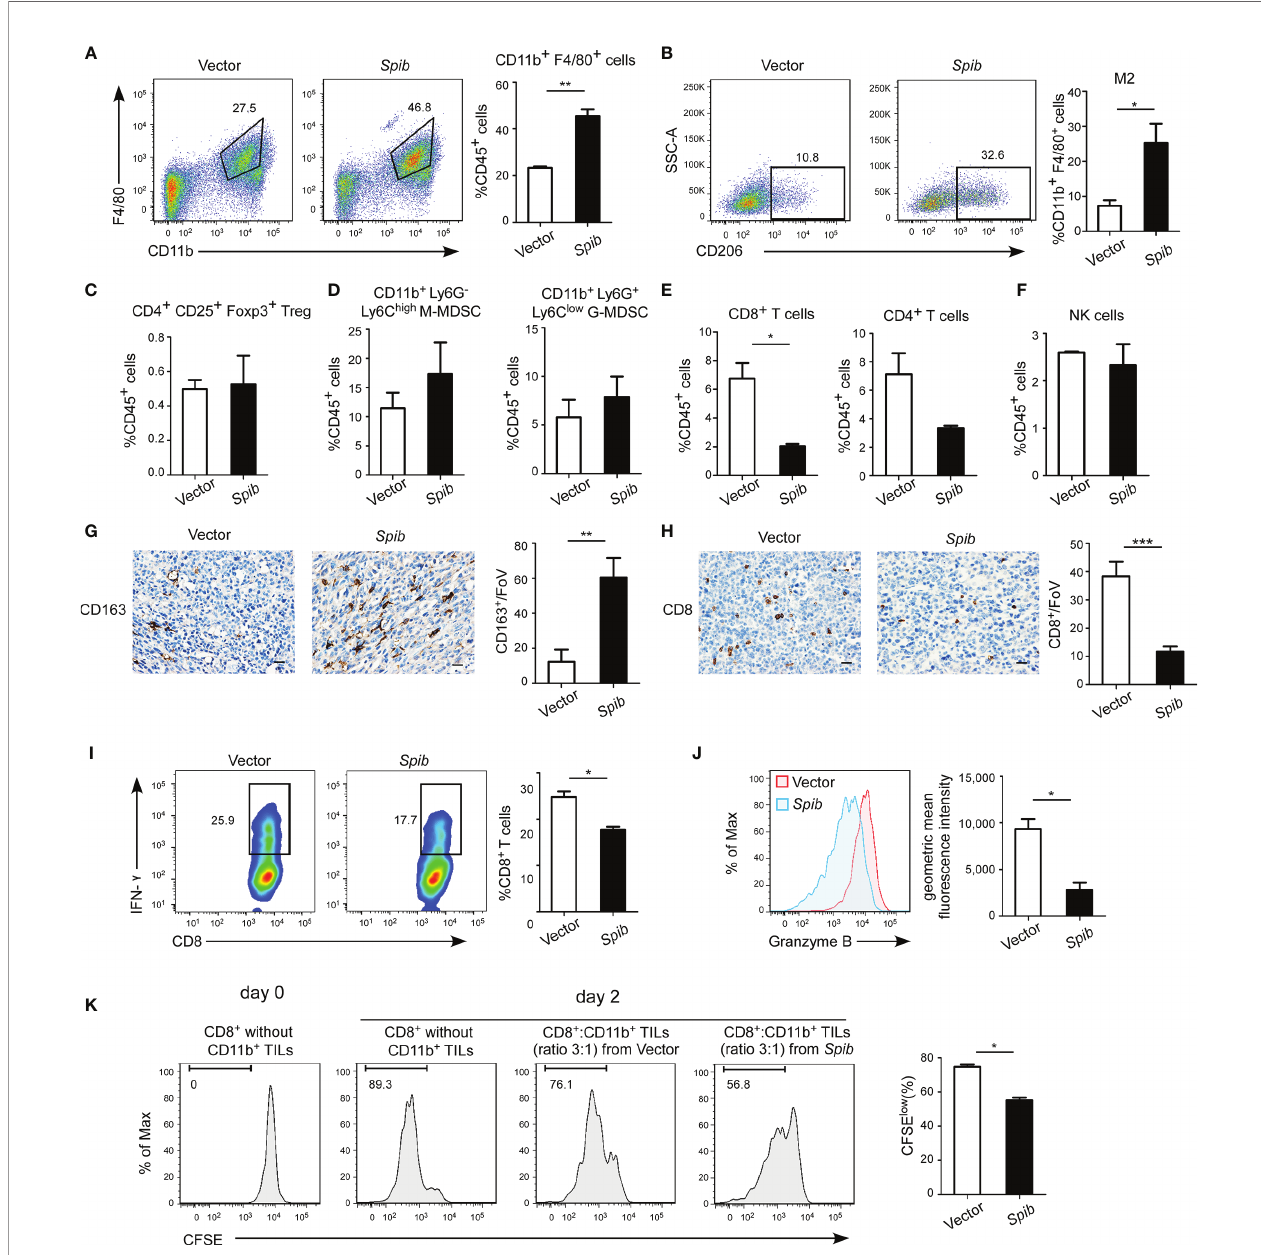
FIGURE 2 | Spib overexpression increases TAM in fi ltration in subcutaneous mouse models. (A) Representative fl ow cytometry pro fi les and percentages of TAMs in CD45 + TILs in subcutaneous tumors. n = 3-4. (B) Representative fl ow cytometry pro fi les and percentages of CD206 + cells in CD11b + F4/80 + cell populations in subcutaneous tumors. n = 3. (C) Quanti fi cation of Tregs in CD45 + TILs in subcutaneous tumors by fl ow cytometry. n = 3-4. (D) Quanti fi cation of monocytic myeloid- derived suppressor cells (M-MDSCs) and granulocytic myeloid-derived suppressor cells (G-MDSCs) in CD45 + TILs in subcutaneous tumors by fl ow cytometry. n = 3-4. (E) Quanti fi cation of CD8 + T cells and CD4 + T cells in CD45 + TILs in subcutaneous tumors by fl ow cytometry. n = 3-4. (F) Quanti fi cation of NK cells in CD45 + TILs in subcutaneous tumors by fl ow cytometry. n = 3-4. (G) Immunostaining with anti-CD163 was performed in subcutaneous tumors derived from LLC1 cells expressing Spib or empty vector. Scale bars, 20 µm. Left, representative pictures of CD163 staining. Right, quanti fi ed CD163 expression in subcutaneous tumors. FoV = fi eld of view. n = 3 mice for each group. (H) Immunostaining with anti-CD8 was performed in subcutaneous tumors derived from LLC1 cells expressing Spib or empty vector. Scale bars, 20 µm. Left, representative pictures of CD8 staining. Right, quanti fi ed CD8 expression in subcutaneous tumors. n = 3 mice for each group. (I, J) CD11b + cells puri fi ed from subcutaneous tumors derived from LLC1 cells expressing Spib or empty vector were cocultured with T cells for 2 days. Quanti fi cation of IFN- g + in CD8 + T cells by fl ow cytometry (I) . Quanti fi cation of the geometric mean fl uorescence intensity of granzyme B in CD8 + T cells (J) . n= 3. (K) In vitro suppressive activity of tumor-in fi ltrating CD11b + cells puri fi ed from subcutaneous tumors derived from LLC1 cells expressing Spib or empty vector. Representative histograms of CD8 + T cell proliferation (left panel). Quanti fi cation of CD8 + T cell proliferation using carboxy fl uorescein succinimidyl ester (CFSE) (right panel). n = 3. Mean ± SD. *P < 0.05. **P < 0.01. ***P <